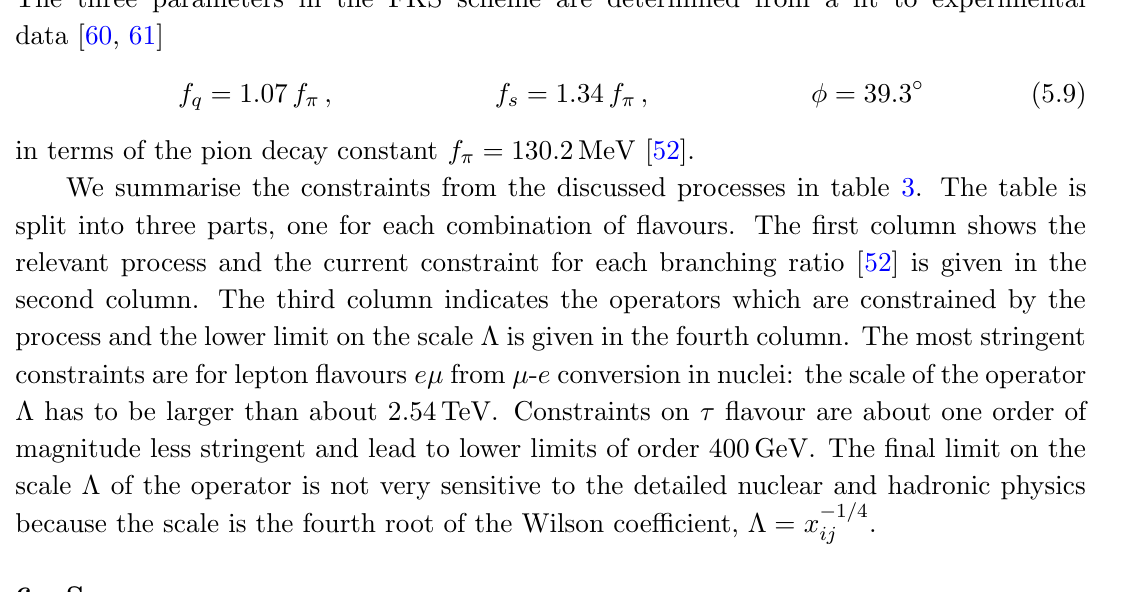
JHEP05(2018)143